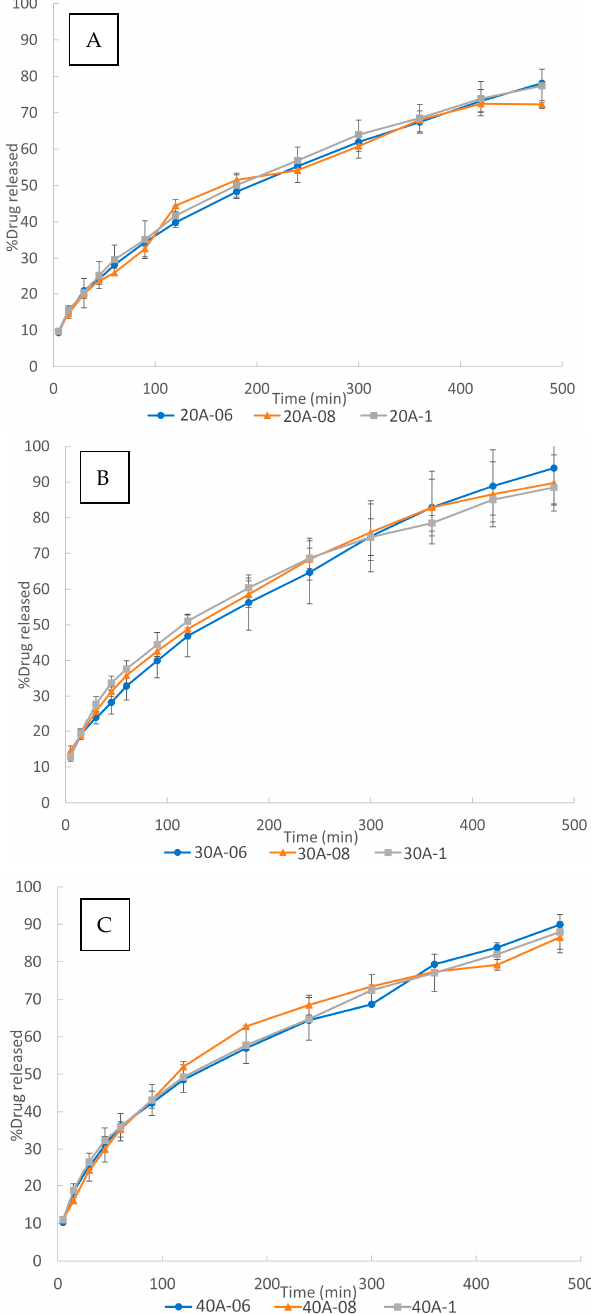
Figure 8. Effect of the internal mesh size of 3DP tablets: ( A ) 20% drug load, ( B ) 30% drug load, and ( C ) 40% drug load.